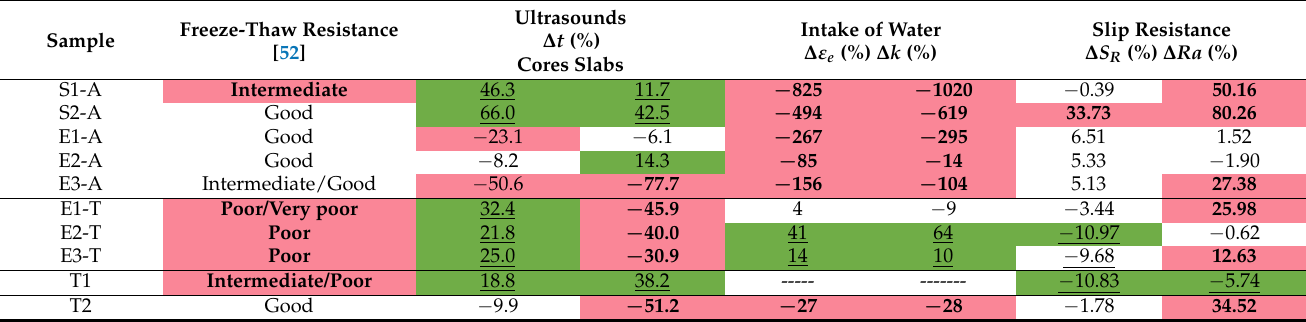
Table 6. Summary of findings for photocatalytically treated